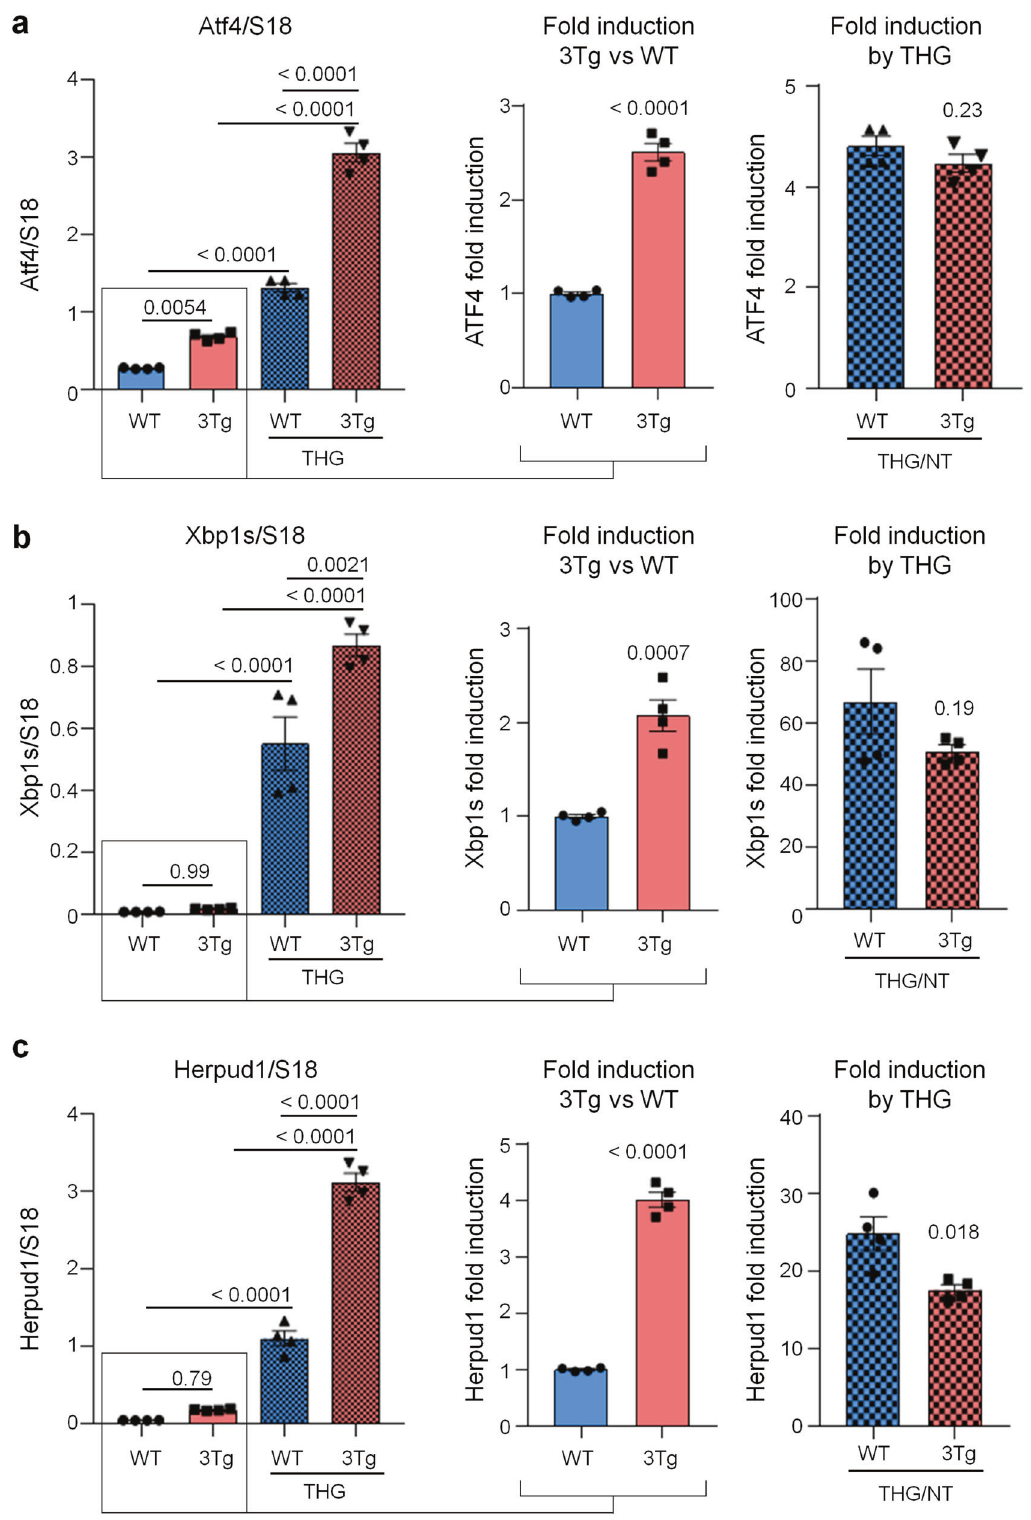
Fig. 3 ER stress/UPR genes induction in WT- and 3Tg-iAstro cells. Real-time PCR of Atf4 ( a ), Xbp1s ( b ) and Herpud1 ( c ) transcripts in cells treated or not with 1 µM THG for 4 h. Data of untreated WT- and 3Tg-iAstro cells (middle plots) and THG treated /untreated cell (right plots) are presented separately. Values represent mean ± SEM Δ C(t) of gene/S18 of four independent experiments for each condition. Left plots were analyzed using ANOVA, with Tukey posthoc test; middle and right plots were analyzed using unpaired two-tail Student ’ s t -test.